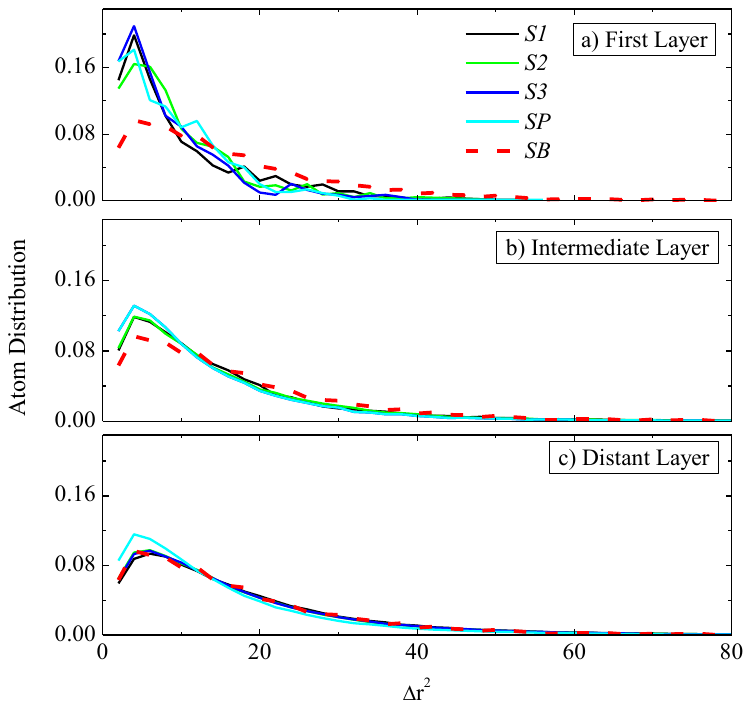
Figure 10. Probability distribution of the mean squared displacements, g j (τ), for all three systems at a specific time period (τ = 5 ps) for three different regimes: ( a ) First layer: 0–6 Å; ( b ) intermediate layer: (10–15 Å for S1, 20–25 Å for S2, 30–35 Å for S3, 15–20 Å for SP) and ( c ) distant layer: (25–30 Å for S1, 45–50 Å for S2, 65–70 Å for S3, 35–40 Å for SP). In all cases the distribution of a bulk system is